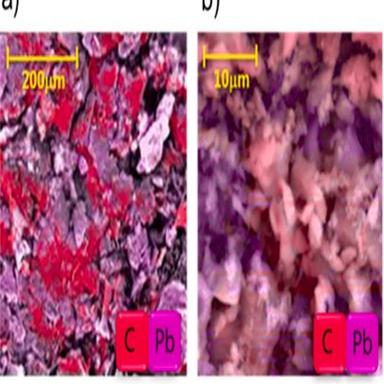
a) EDX-SEM analyses of lead-labeled GNP-M25, b) EDX-SEM analyses of abraded Epoxy/1.0wt%GNP-M25-Pb particles.